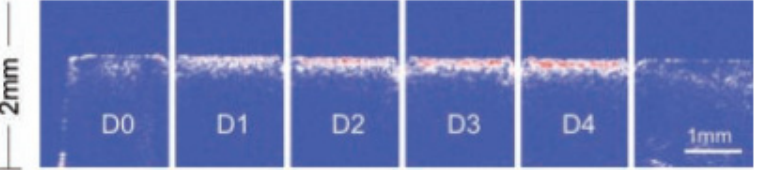
Figure 1. PS-OCT B-scan of bovine enamel in the perpendicular axis. D0 represents the sound area and D1–D4 represent areas demineralized for 1–4 days. A red-white-blue color chart was used, with red indicating strong reflectivity and blue indicating low reflectivity. This figure was adapted from [49].